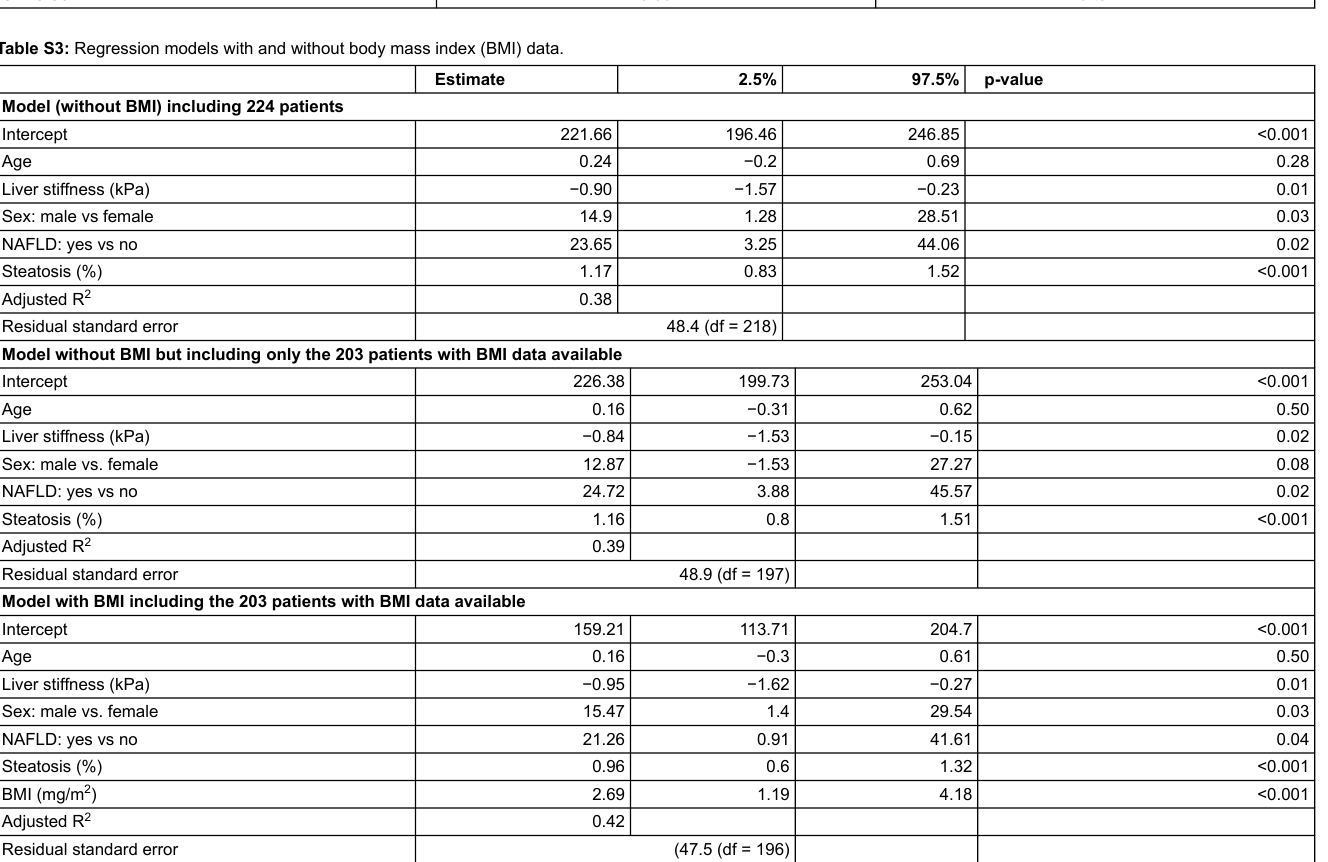
Table S3: Regression models with and without body mass index (BMI)